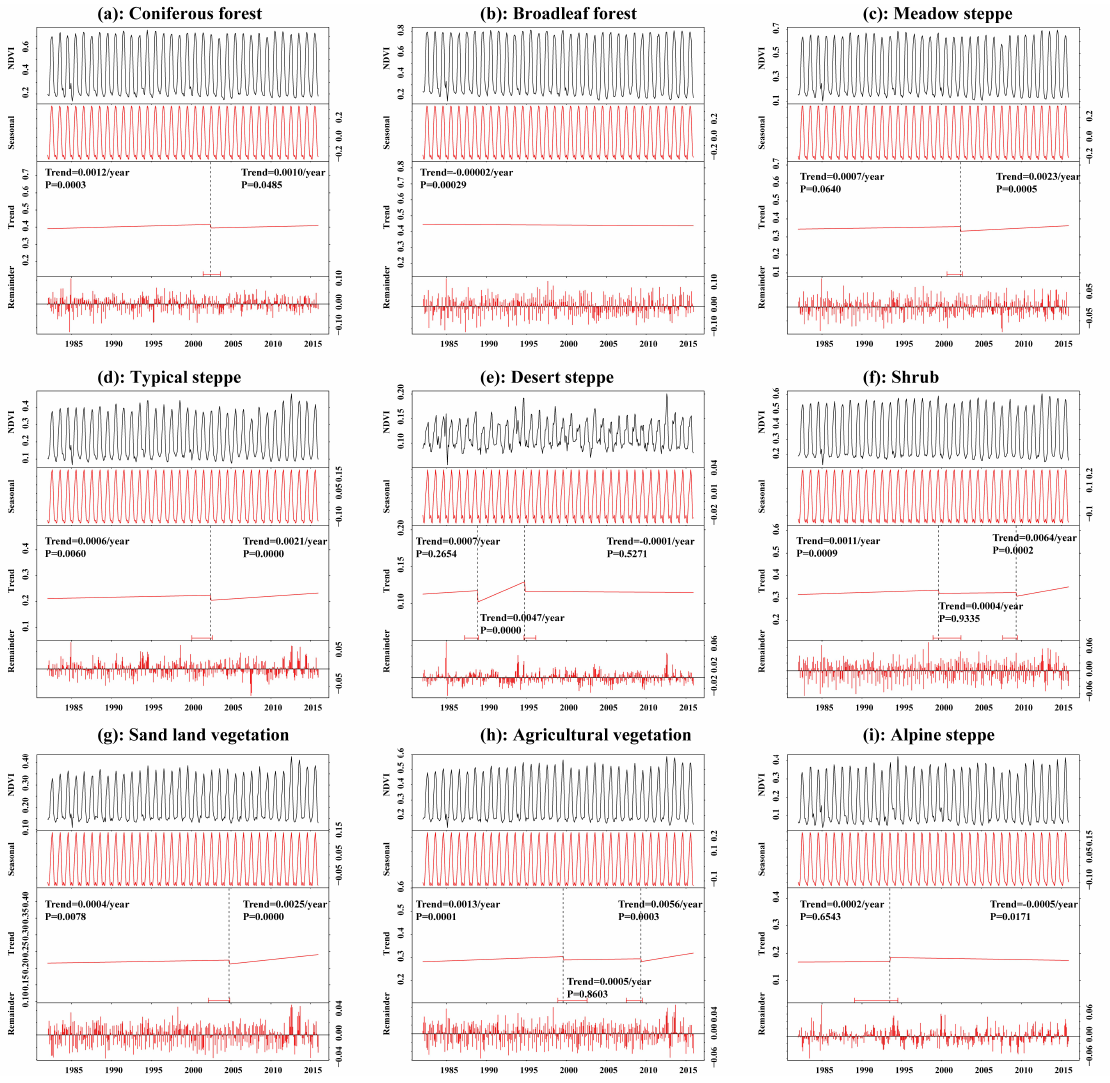
Figure 4. Abrupt breaks for additive seasonal and trend method (BFAST)-detected shifts in monthly NDVI for 1982– 2015 in the different vegetation and steppe types of the Mongolian Plateau. ( a ) Coniferous forest, ( b ) Broadleaf forest, ( c ) Meadow steppe, ( d ) Typical steppe, ( e ) Desert steppe, ( f ) Shrub, ( g ) Sand land vegetation, ( h ) Agricultural vegetation, ( i ) Alpine steppe. Table 2. Percentage of the total area for all vegetation and steppe types in the Mongolian Plateau, split by the number of breakpoints (BPs) detected between 1982 and